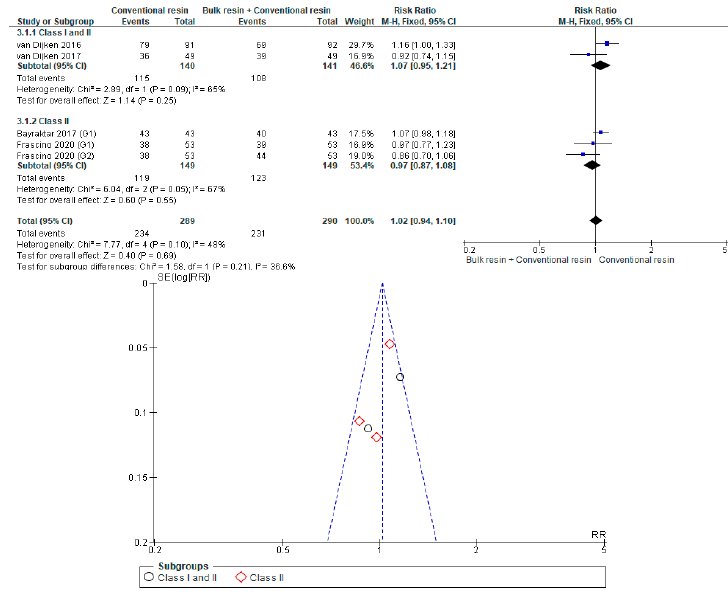
Figure A11. Adequate Marginal Adaptation: Conventional Resin versus Bulk Resin Covered with Conventional Resin According to Type of Restoration.